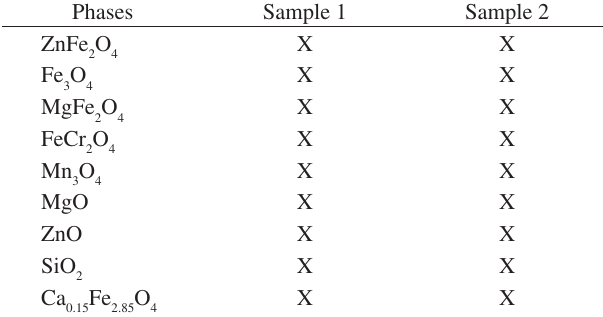
Table 4. Phases o�tai�ed i� the XRD a�alysis o� the st�died EAFD